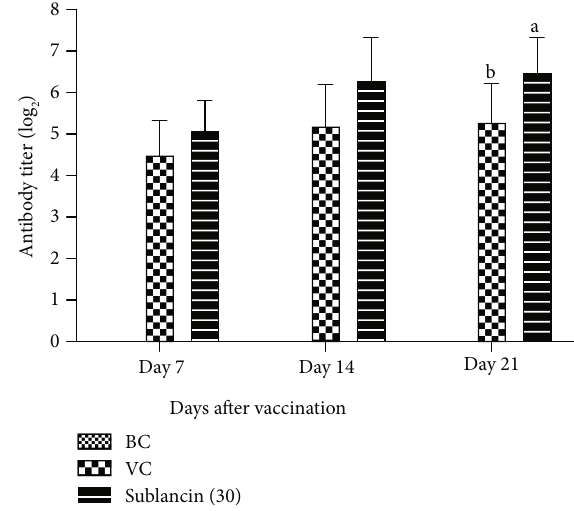
Figure 2: The dynamic changes of antibody titer in each group ) in Exp. 2. a,b Bars in the same day without the same (log 2 superscripts di ff er signi fi cantly ( P < 0 : 05